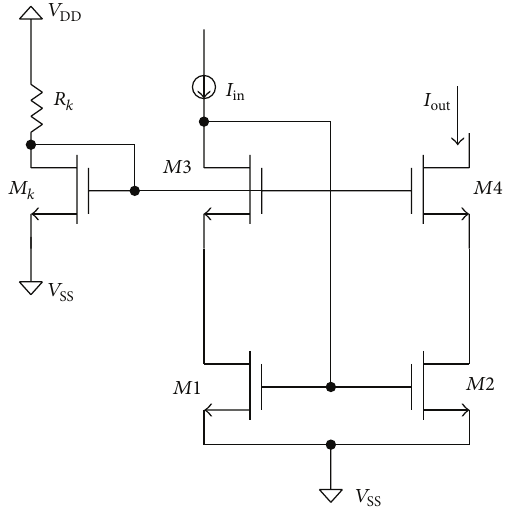
Figure 1: Conventional low voltage cascode current mirror (LVCCM), when input current is fed at the drain terminal of transistor 𝑀3 .